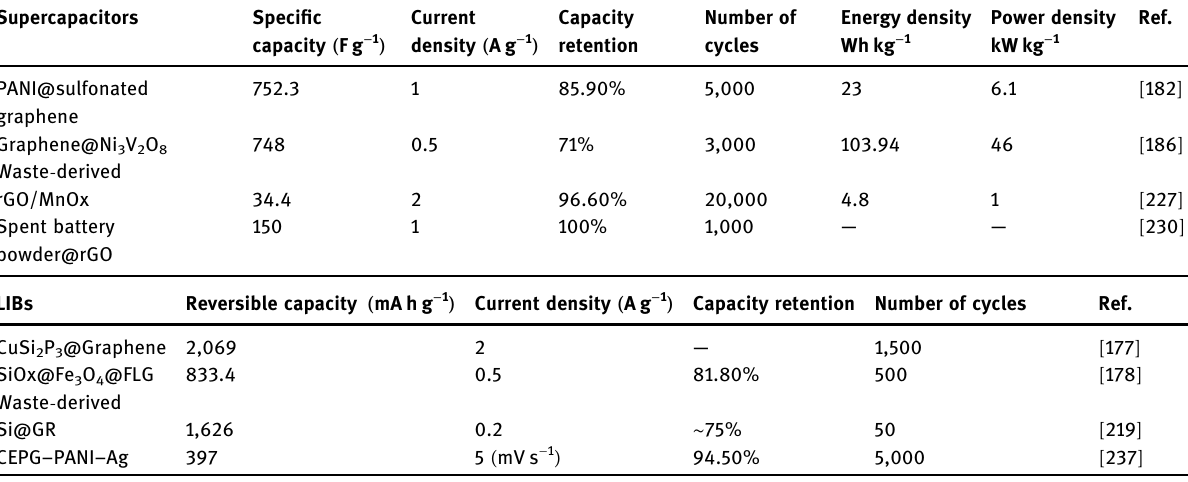
Table 5: Literature of waste - generated nanomaterials for comparing their performance outcomes